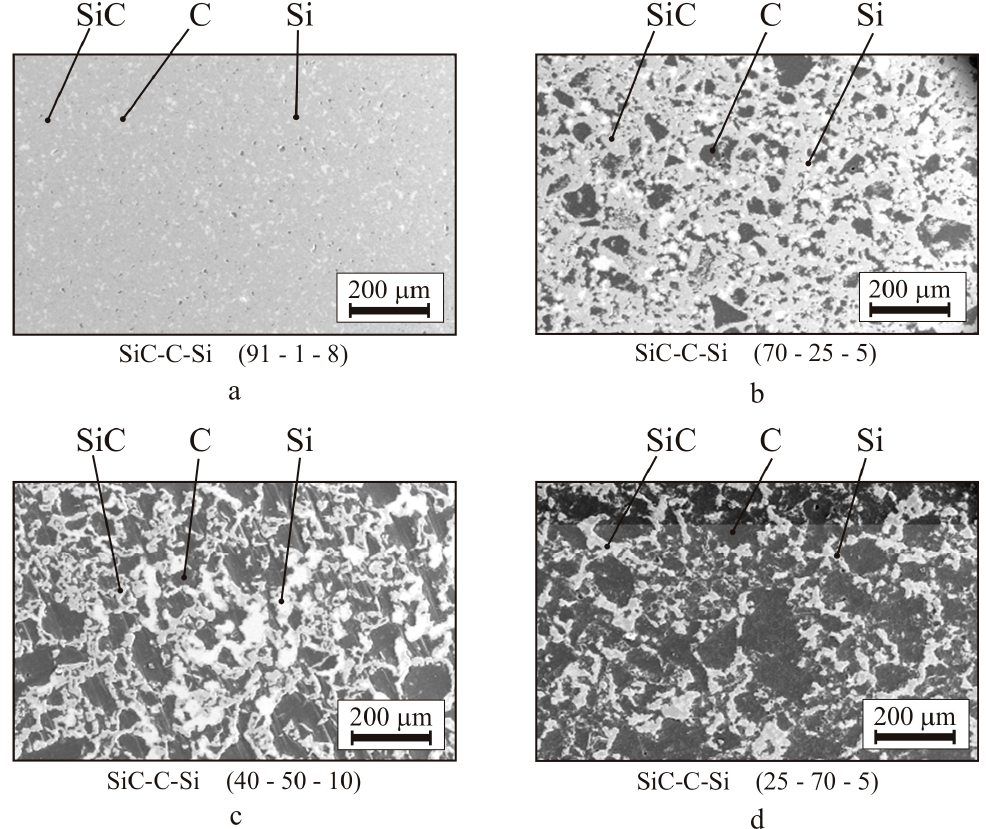
Figure 8. Microstructure of SiC-based ceramics with various phase compositions SiC/C/Si: ( a ) 91/1/8 %wt. (carbon blank density is 0.9 g/cm 3 ), ( b ) 70/25/5, ( c ) 40/50/10, and ( d ) 25/70/5 (carbon blank density is 1.46 g/cm 3 ).